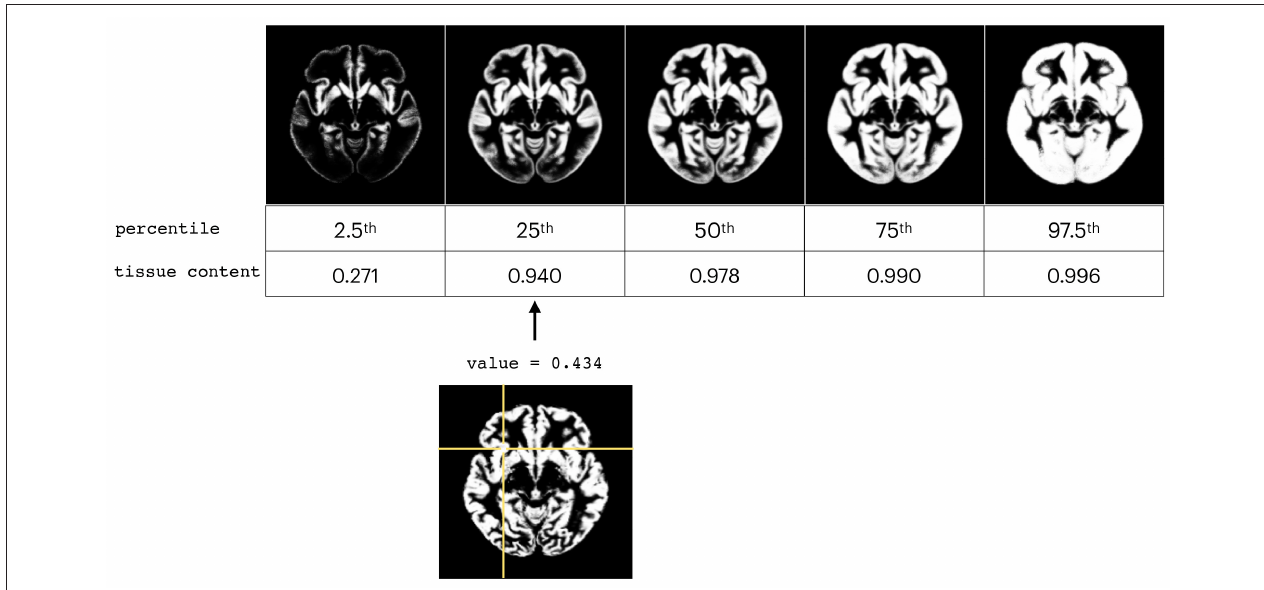
FIGURE 2 | Presentation of different levels of percentile maps for GM atlas (top) and comparison with one individual subject (bottom) .